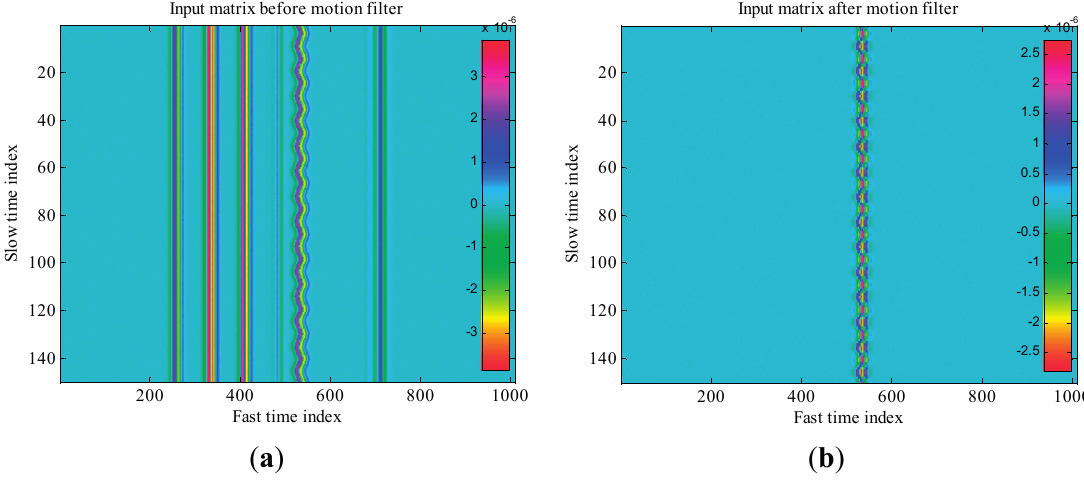
Figure 12. Example of matrix R . ( a ) Before motion filtering; ( b ) After motion